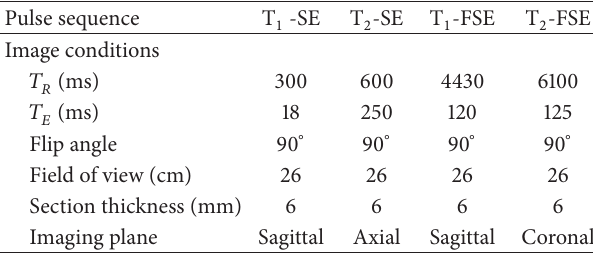
Table 3: MRI sequences performed on each tag at 0.3 T/12.7MHz for testing device